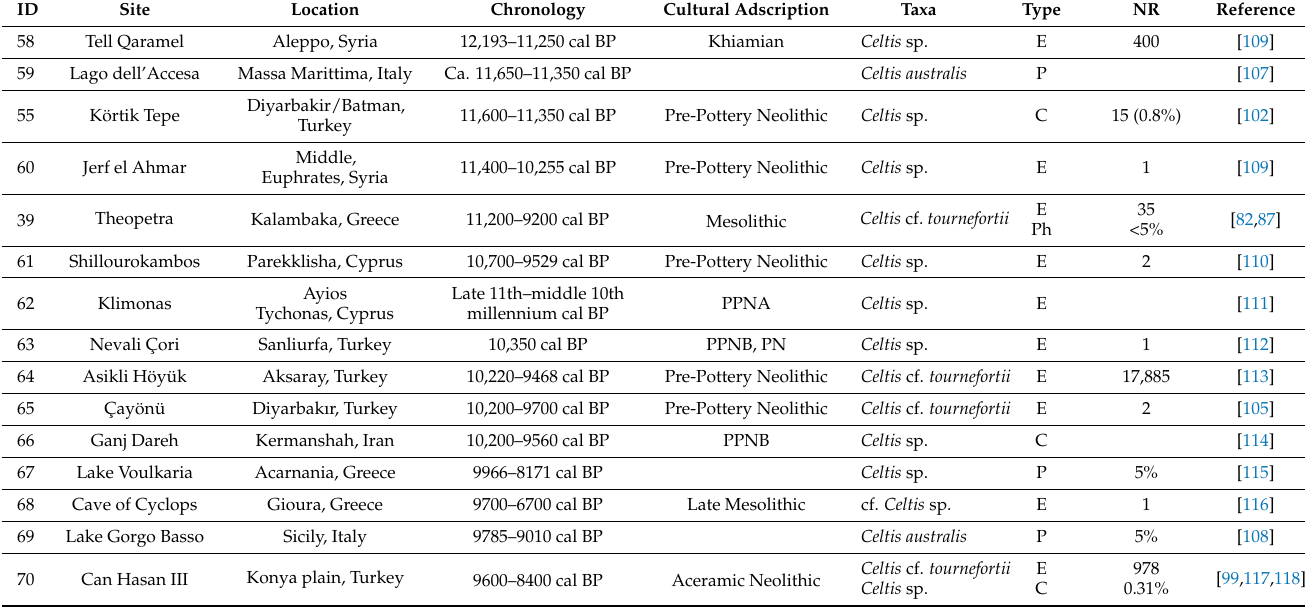
Table 5. Middle Holocene sites where Celtis remains were reported (types of remains: wood char- coal (C), endocarp (E), pollen (P)).